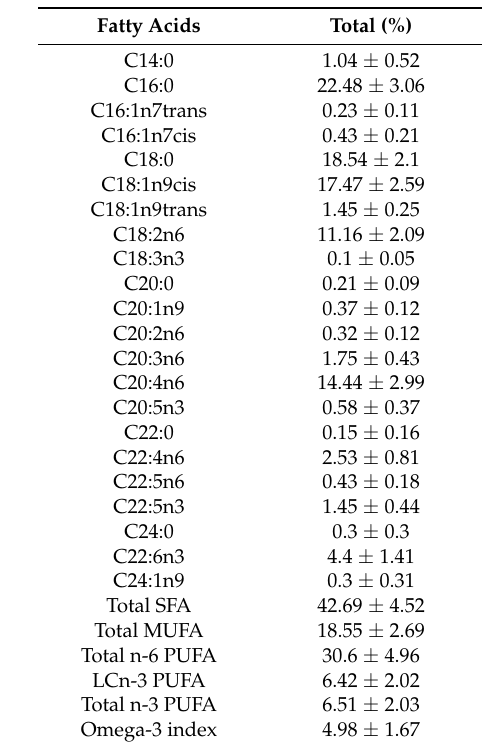
Table 2. Fatty acids percentages (mean ± standard deviation) in blood cell membranes at baseline in the study